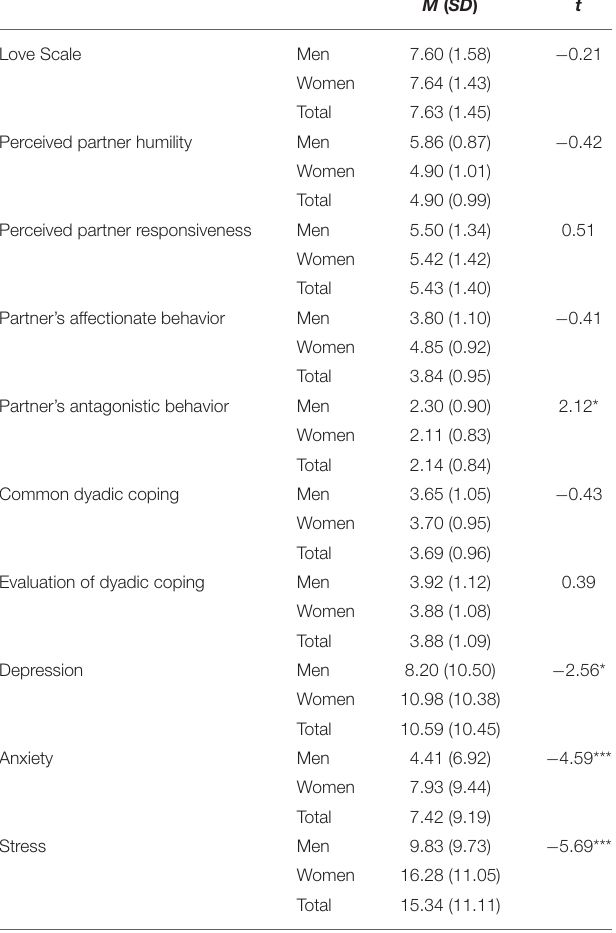
TABLE 2 | Descriptive